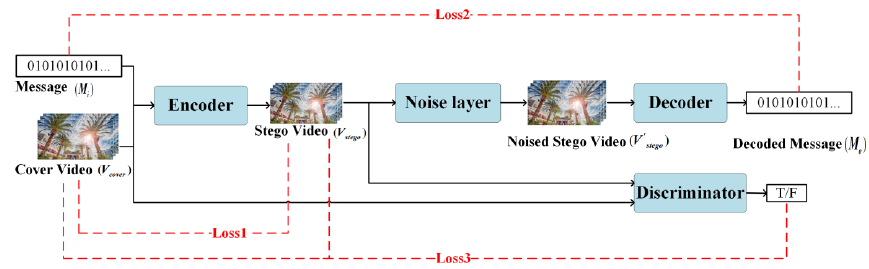
Figure 1. Network architecture.